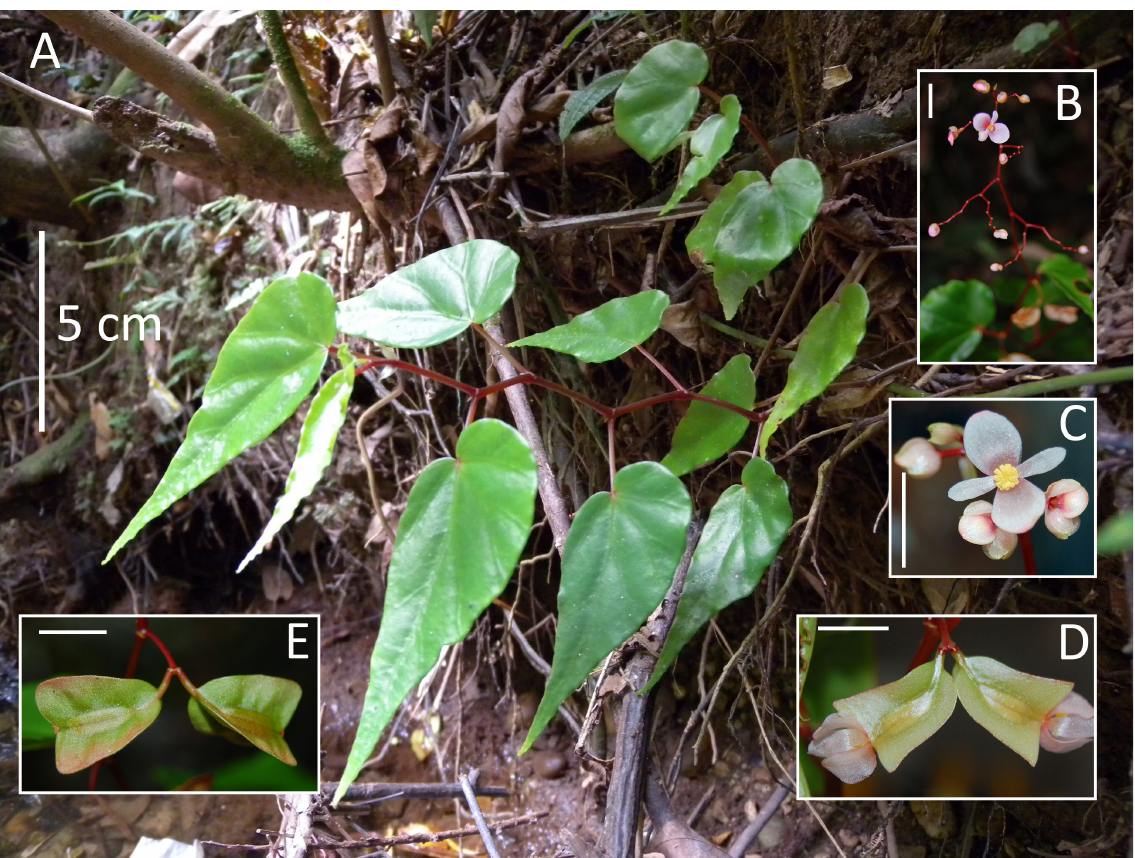
Fig. 6. Begonia harauensis Girm. sp. nov. A . Habit (Lembah Harau Nature Reserve, Hughes, M. & Taufiq, A. MH 1556 ). B . Male inflorescence. C . Male flower. D . Pair of female flowers showing ovary. E . Unripe fruit. Insets from plant cultivated in Bogor Botanical Garden (accession number B200608257/ JS 436, derived from material collected in Lembah Harau). Scale bars on insets = 1